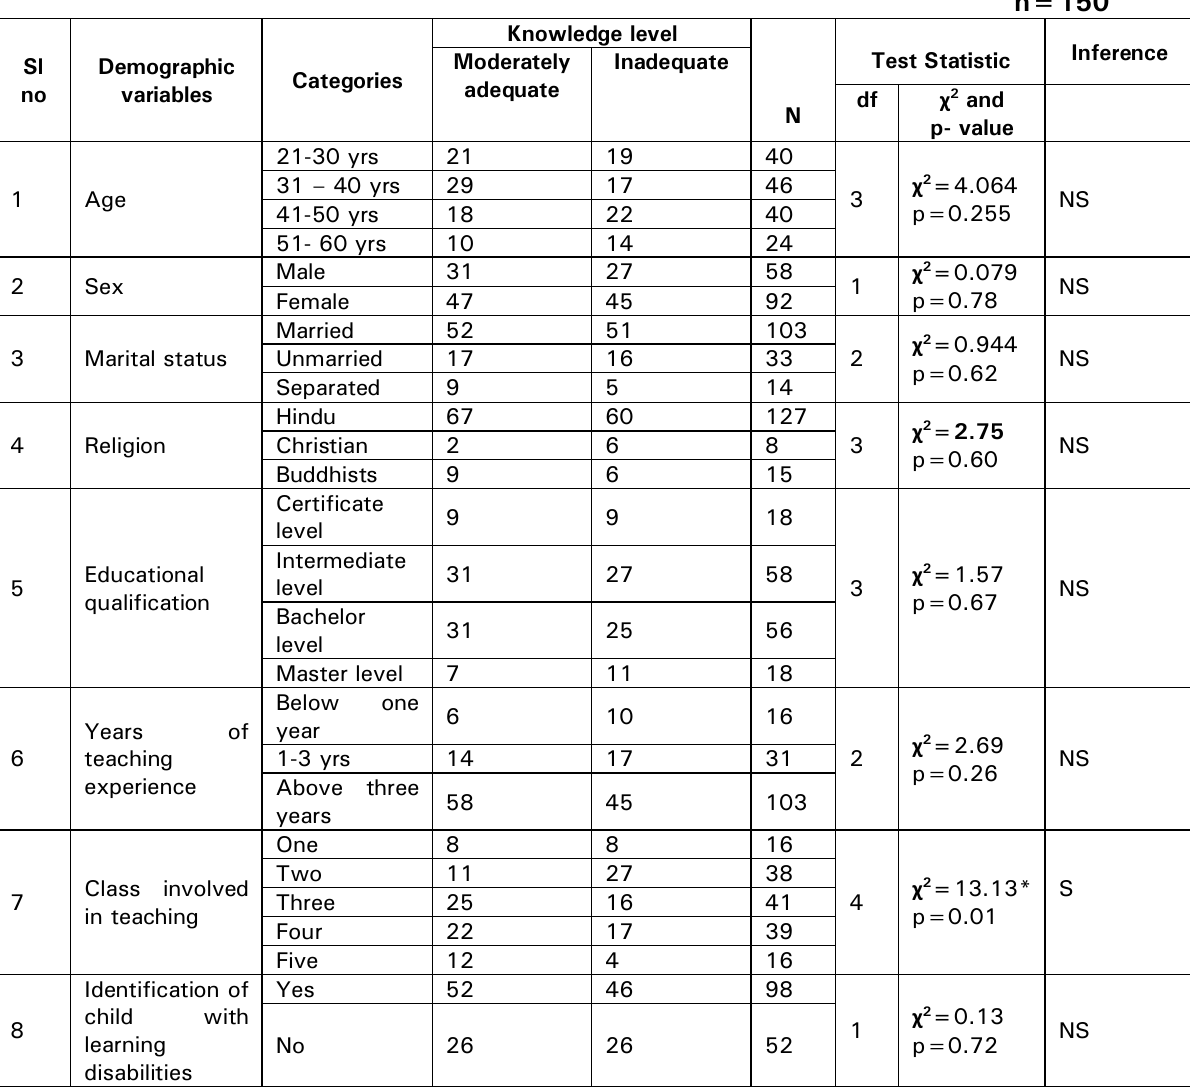
Table - 3 : Association of Level of knowledge of primary school teachers with their demographic variables.